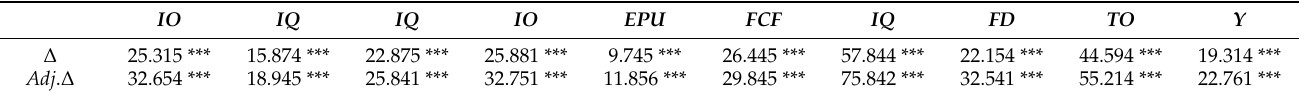
Table 8. Result of